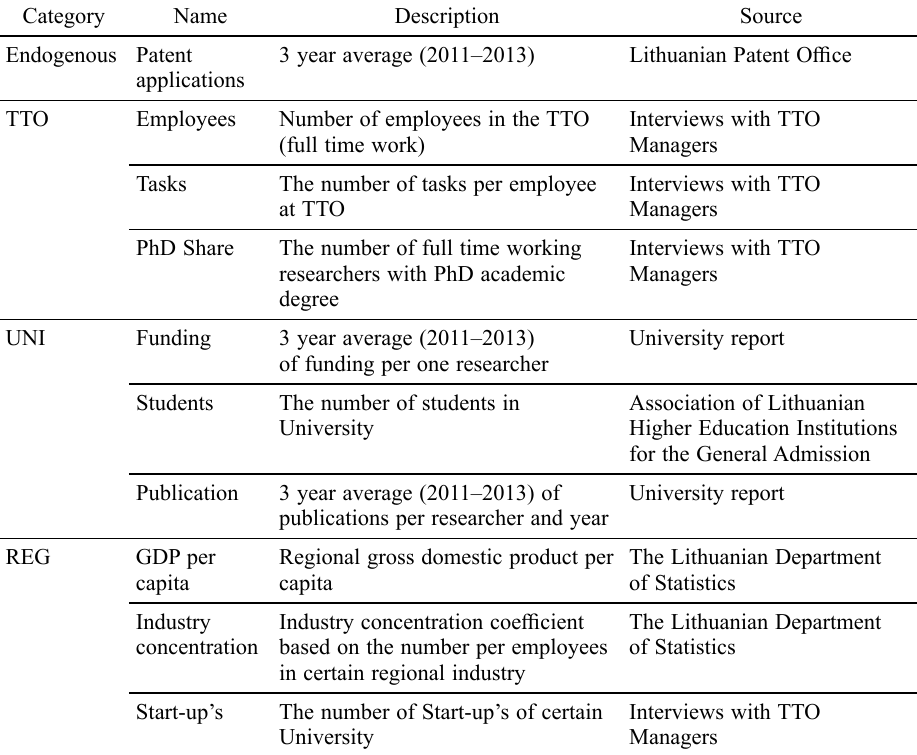
Table 1. Variables and measurement of the research method (adapted from Hulsbeck et al.